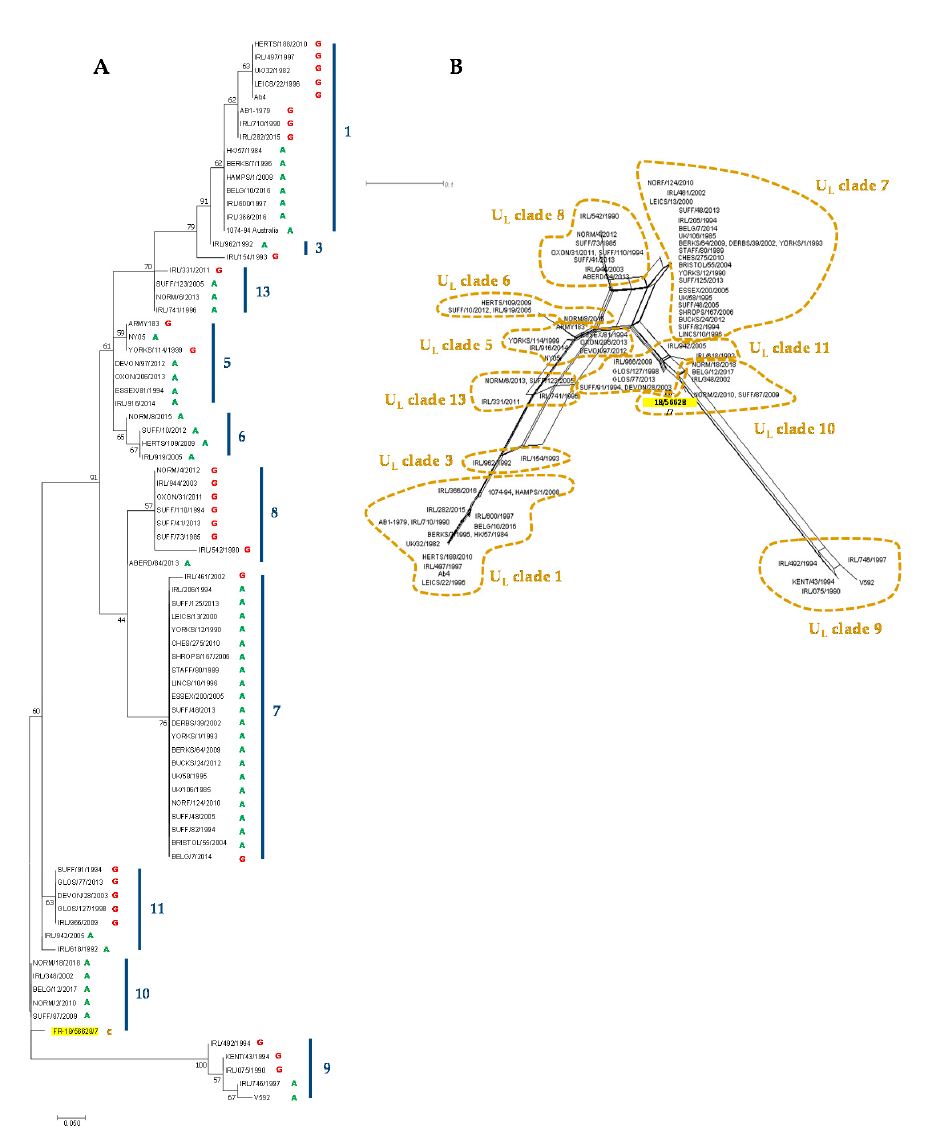
Figure 7. Maximum likelihood phylogenic tree based on Jones–Taylor–Thornton model ( A ) and neighbour joining network ( B ) both built from multi-locus sequence typing (MLST) amino acid sequences from 46 strains from UK, 1 strain from China, 1 strain from the US, 1 strain from Australia, 9 other strains from France and Belgium including the new strain FR-56628 (highlighted in yellow) and 22 strains from Ireland.